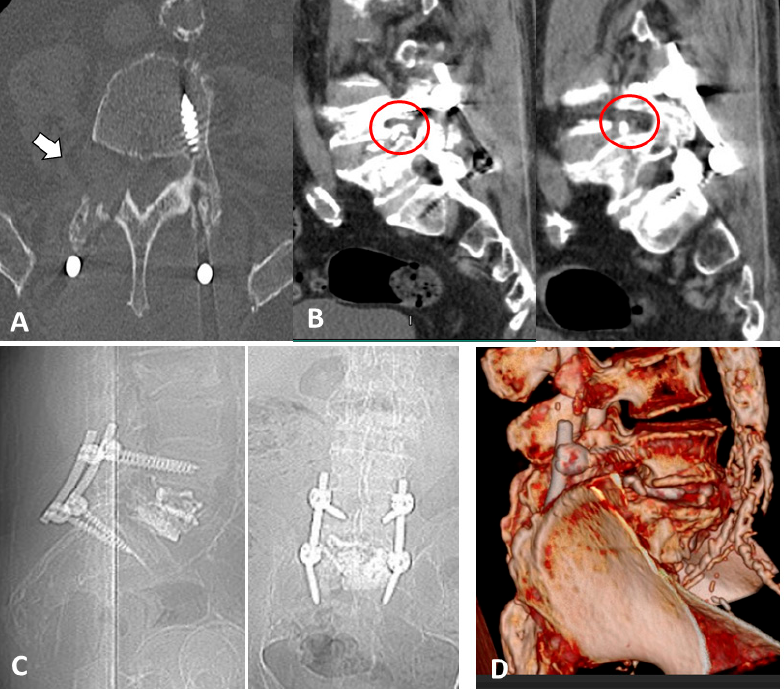
Figure 5. The 3-month follow-up, post-operative imaging. ( A ) Axial CT scan at the L4–L5 right neuroforamen, showing the foramen enlargement after hemilaminectomy and foraminotomy (white arrow); ( B ) sagittal CT scans showing neuroforamen enlargement over cement leakage (red circle); ( C ) sagittal (left) and coronal (right) post-operative X-rays; ( D ) 3D CT reconstruction of the lumbar spine: foramen enlargement over cement